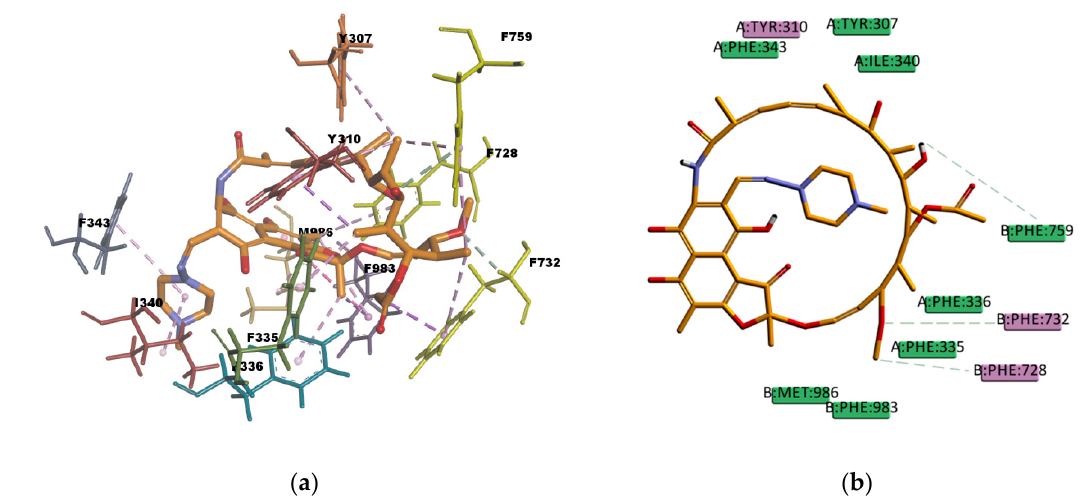
Figure 12. Rifampin (RMP) top-ranked pose obtained with CDOCKER algorithm. ( a ) 3D view of RMP